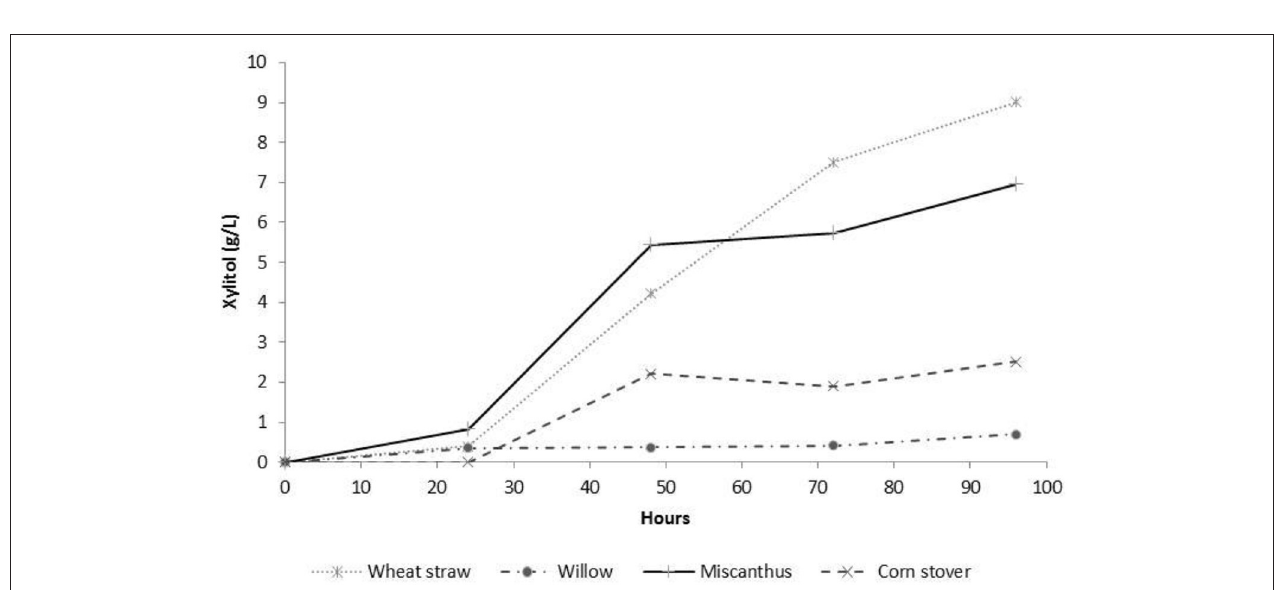
FIGURE 5 | Flask bioconversion of L16 SE-PT feedstock hydrolysate without detoxification for xylitol production utilizing Schefferomyces shehatae Y6603 strain n =